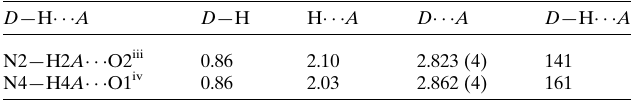
Table 3 Hydrogen-bond geometry (A˚ , (cid:3) ) for 2 .